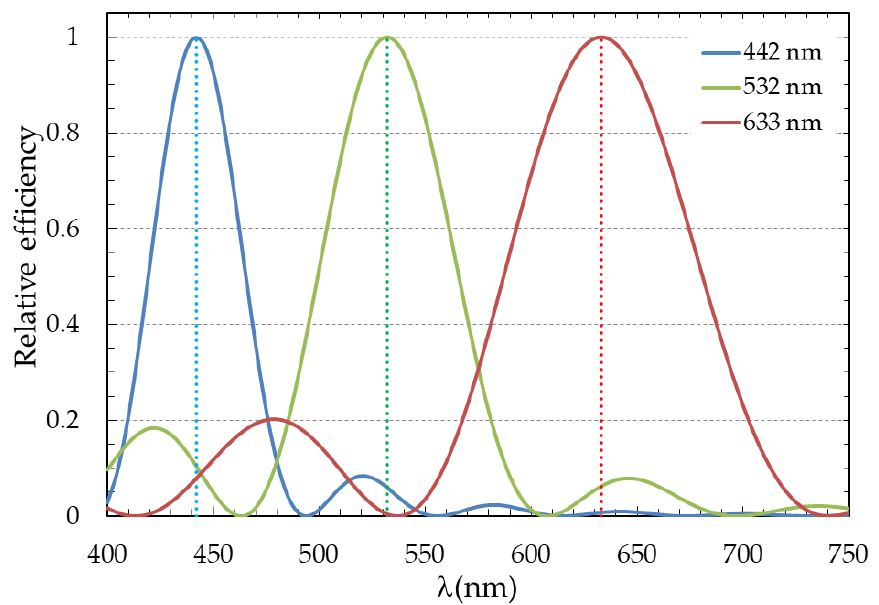
Figure 3. Chromatic selectivity curves for three holograms recorded with three different wavelengths (633 nm, 532 nm and 442 nm) with 50º between the object and reference beams.